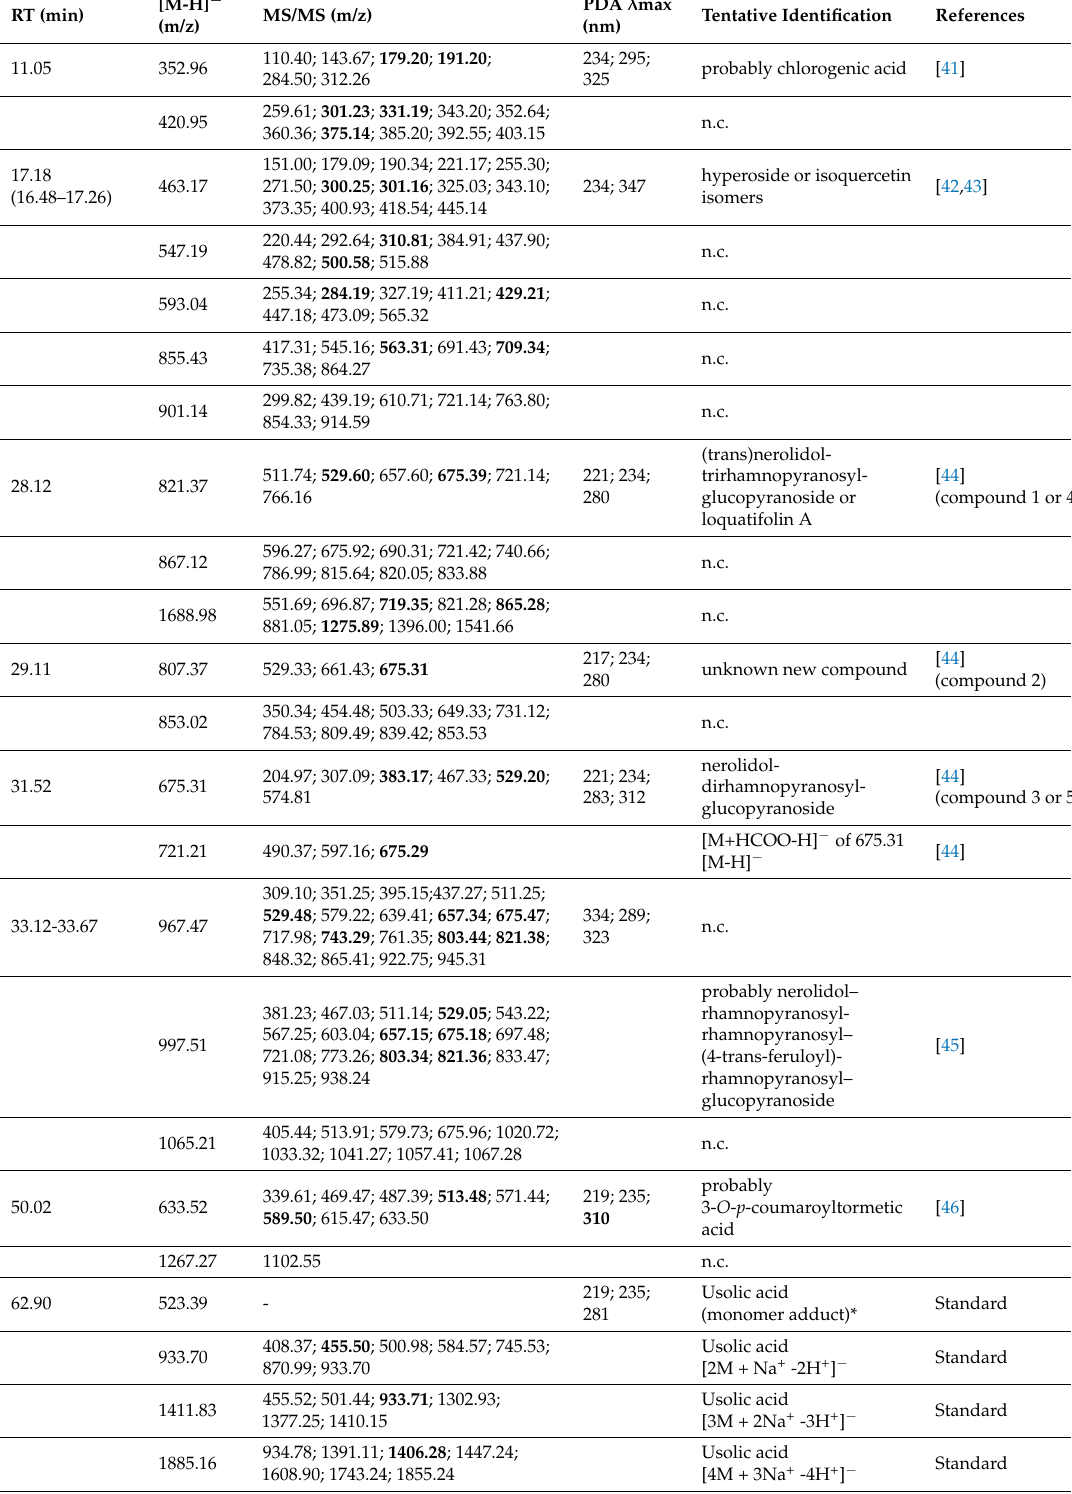
Table 3. Retention times (RT), MS data, and tentatively identified compounds in the E. japonica extract. RT